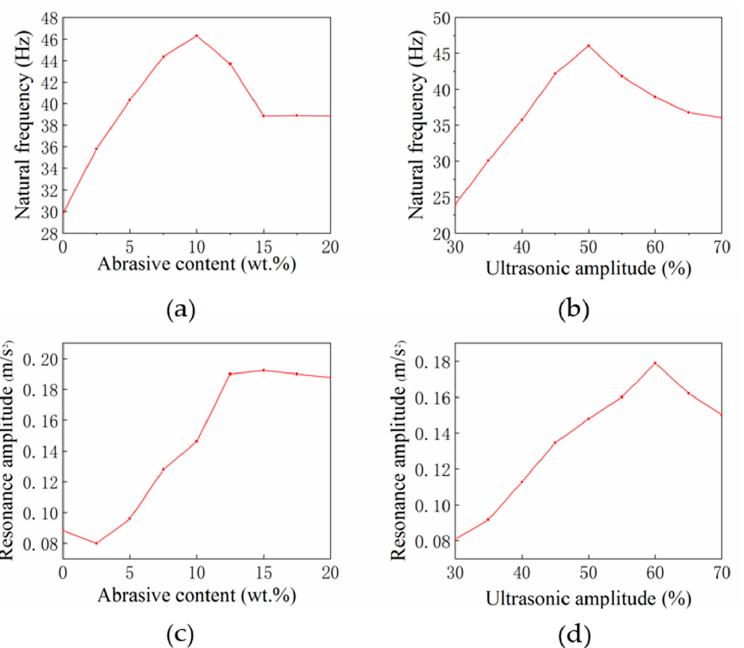
Figure 9. Graph of data in Tables 2 and 3. ( a ) Relationship between abrasive content and material natural frequency in SiC suspension; ( b ) Relationship between ultrasonic amplitude and natural frequency of material; ( c ) Relationship between abrasive content in SiC suspension and resonance amplitude of the material; ( d ) Relationship between ultrasonic amplitude and material resonance amplitude.